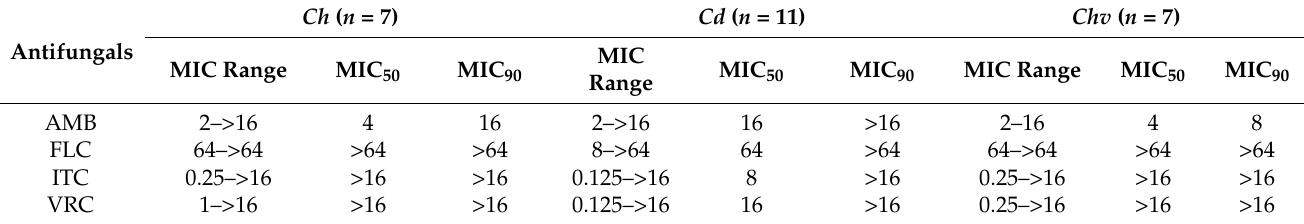
Table 3. MIC ranges, MIC 50 and MIC 90 values of the C. haemulonii species complex to classical antifungal